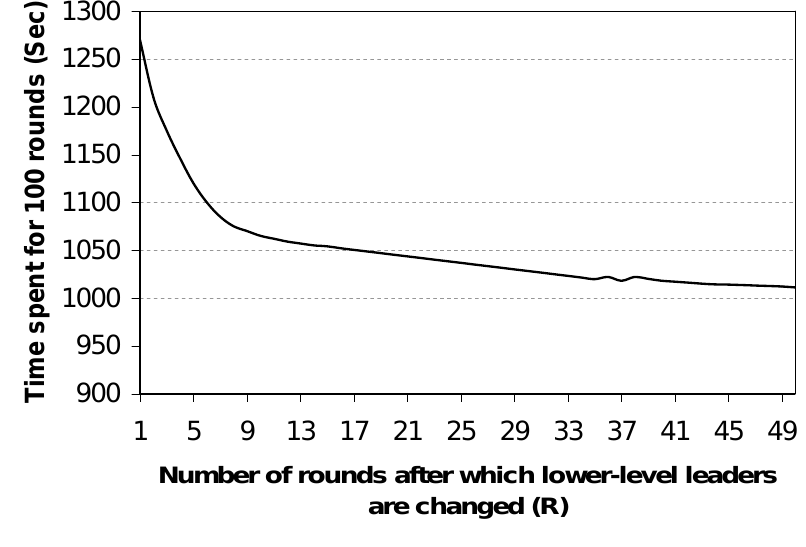
Figure 15. Leader selection time vs . time